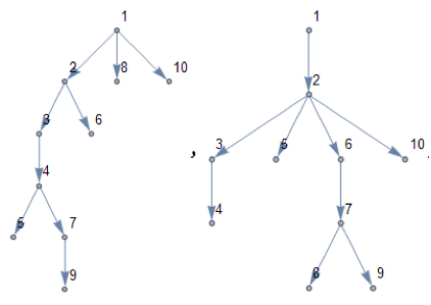
Figure 2. Parent chromosomes a) and b)